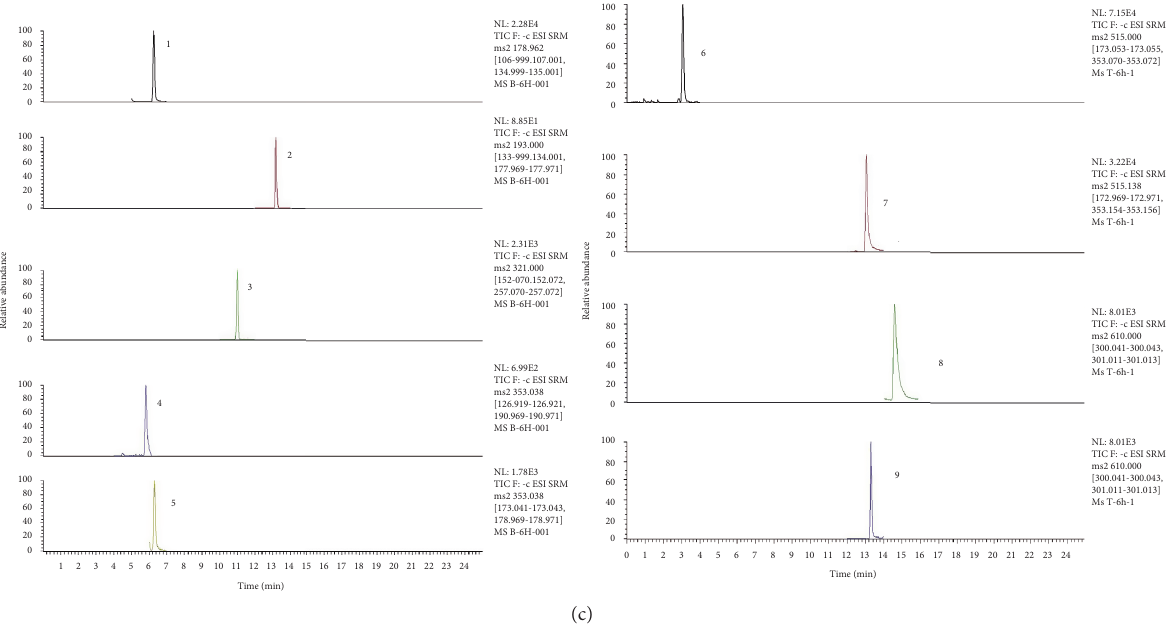
Figure 2: SRM chromatograms of (1) caffeic acid; (2) ferulic acid; (3) chloramphenicol (IS); (4) chlorogenic acid; (5) cryptochlorogenic acid; (6) neochlorogenic acid; (7) isochlorogenic acid B; (8) isochlorogenic acid C; (9) rutin: (a) blank rat sample, (b) plasma spiked with 8 analytes and IS, and (c) plasma sample obtained from a rat 4 h after oral